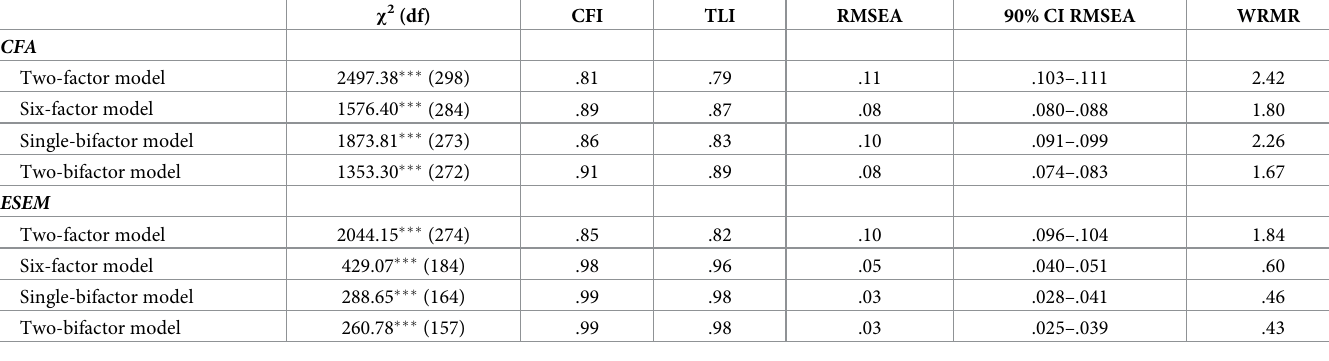
Table 1. Goodness-of-fit indices for CFA and ESEM